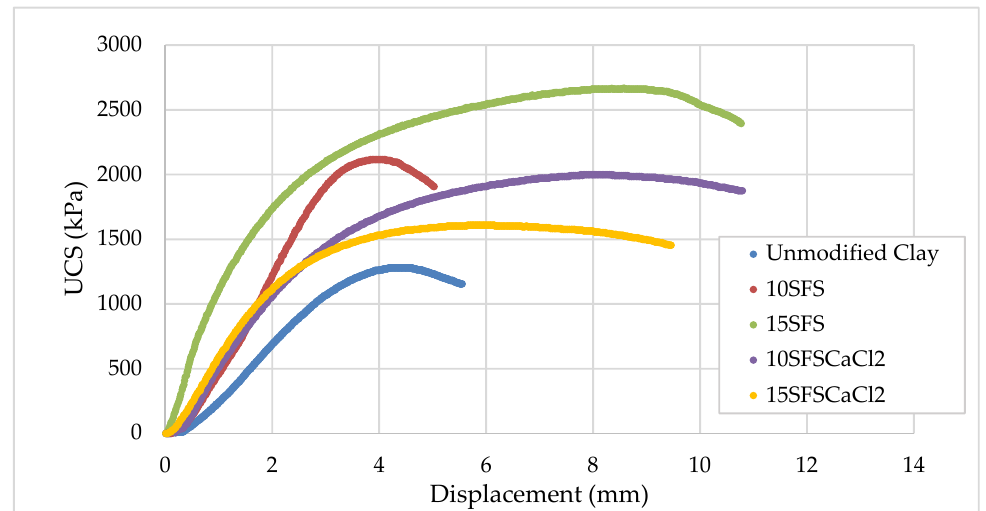
Figure 6. Average stress-displacement curve for each mixture.